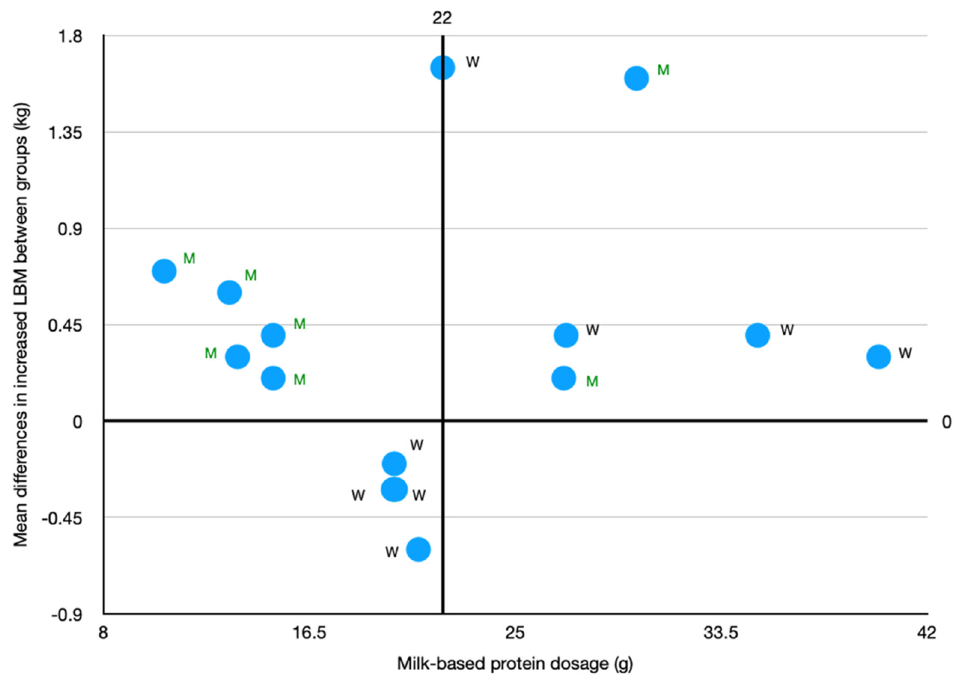
Figure 9. Relationship between milk-based protein dosage and the difference between milk-base protein and control supplementations on RT-induced LBM/FFM gain. Each blue dot represents a single study. M: milk protein; W: whey protein.